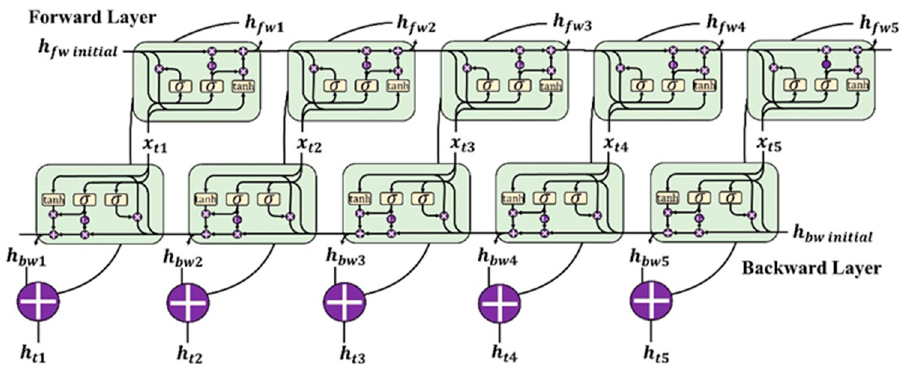
Figure 4. The typical structure of a bi-GRU network with two single layers.